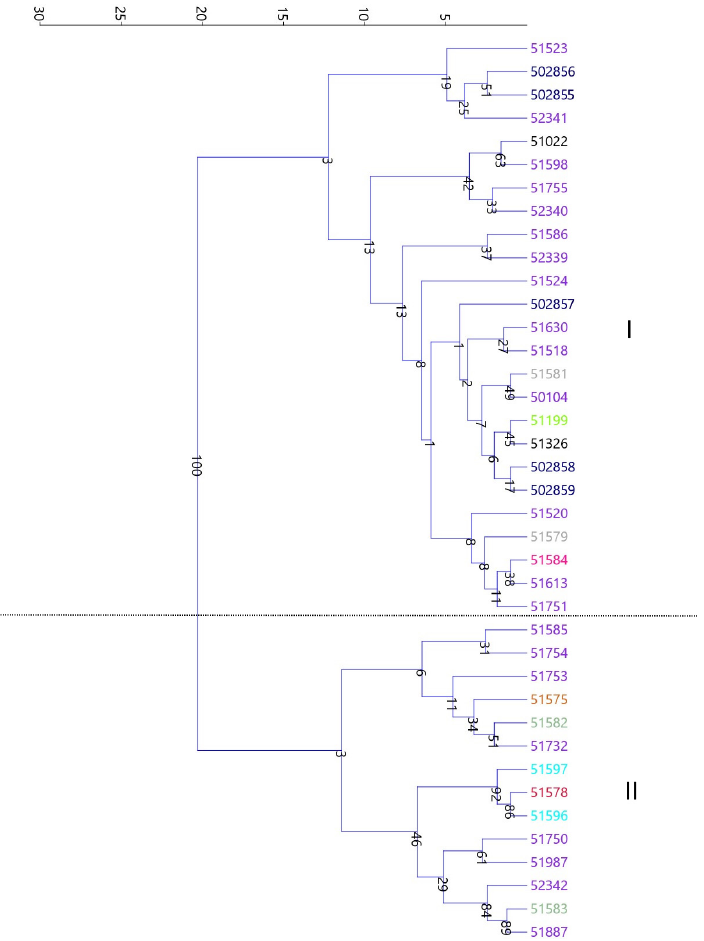
Figure 2. Ward’s dendrogram of 39 accessions of Avena strigosa L. The accessions were assigned with the numbers used in Table 1 and the colors indicating the origin countries of the samples used in Figure 1.